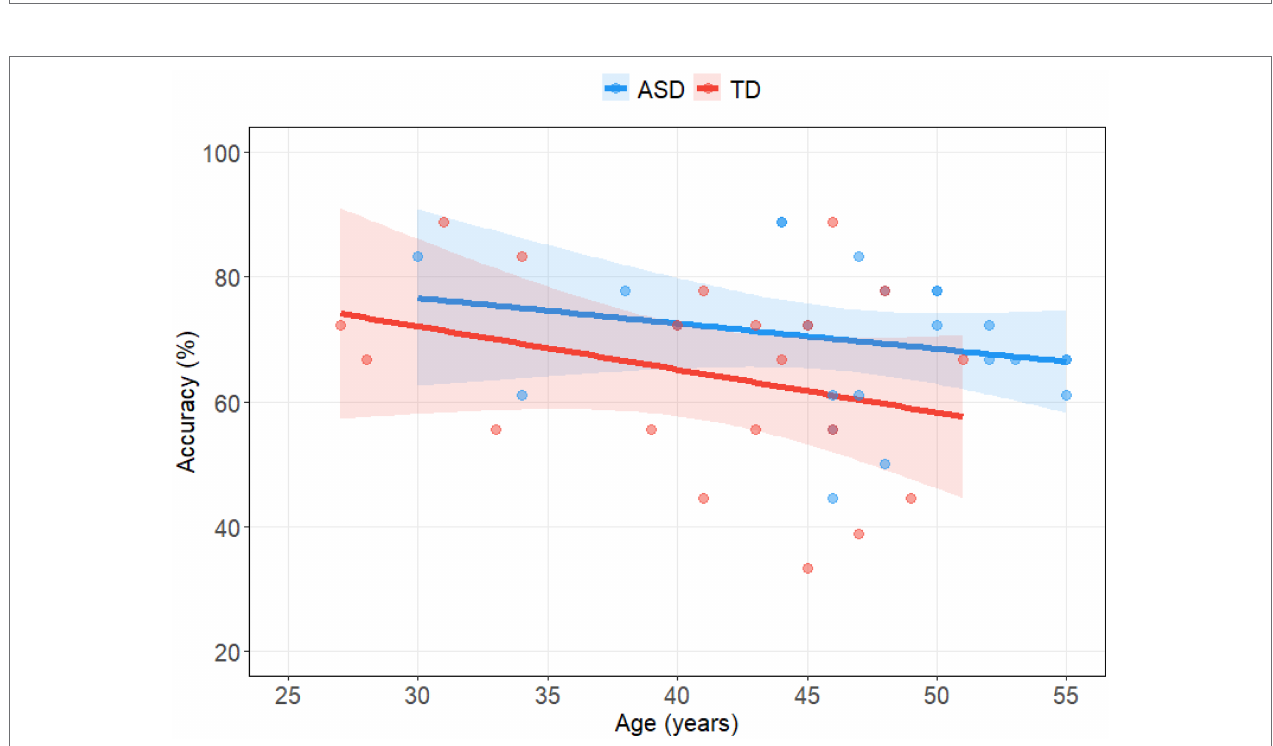
FIGURE 4 | Correlations of age and average accuracies in Embedded Figure Tasks (EFT) in ASD group (blue) and TD group (red). One point represents the age and mean accuracy over all Embedded Figure Task (EFT) trials of one participant. Linear regression lines with confidence bands depict negative slopes in both